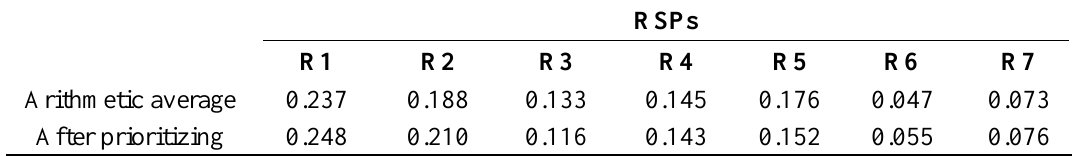
Table 6. Comparison between two types of importance for each RSP.